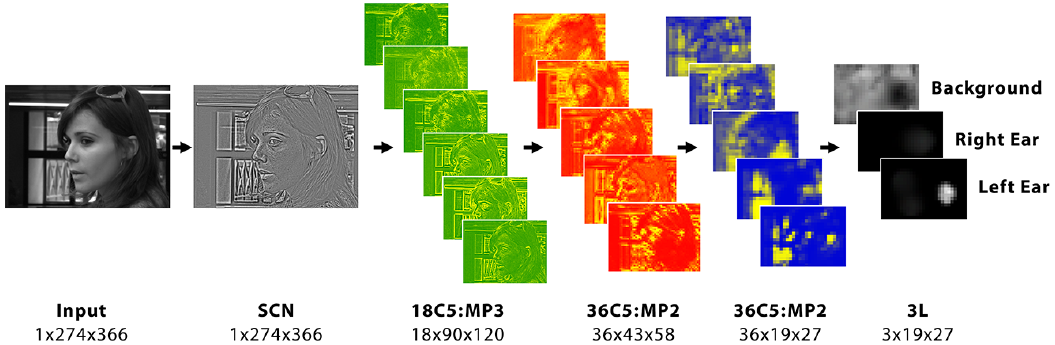
Figure 6. Shared map execution of one of the CNNs over a sample input